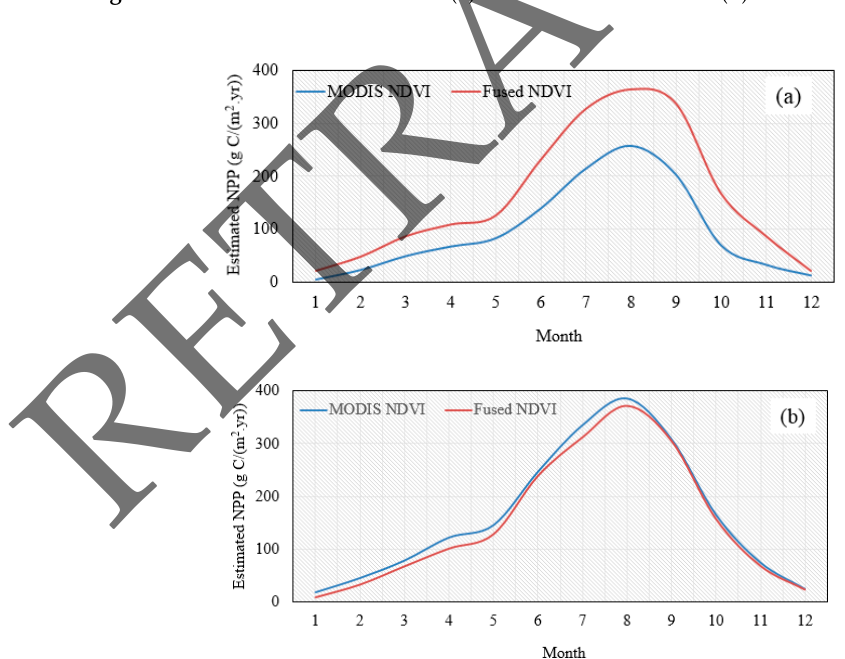
Figure 8. NPP estimations based on ( a ) MODIS NDVI data and ( b ) the fused NDVI data.